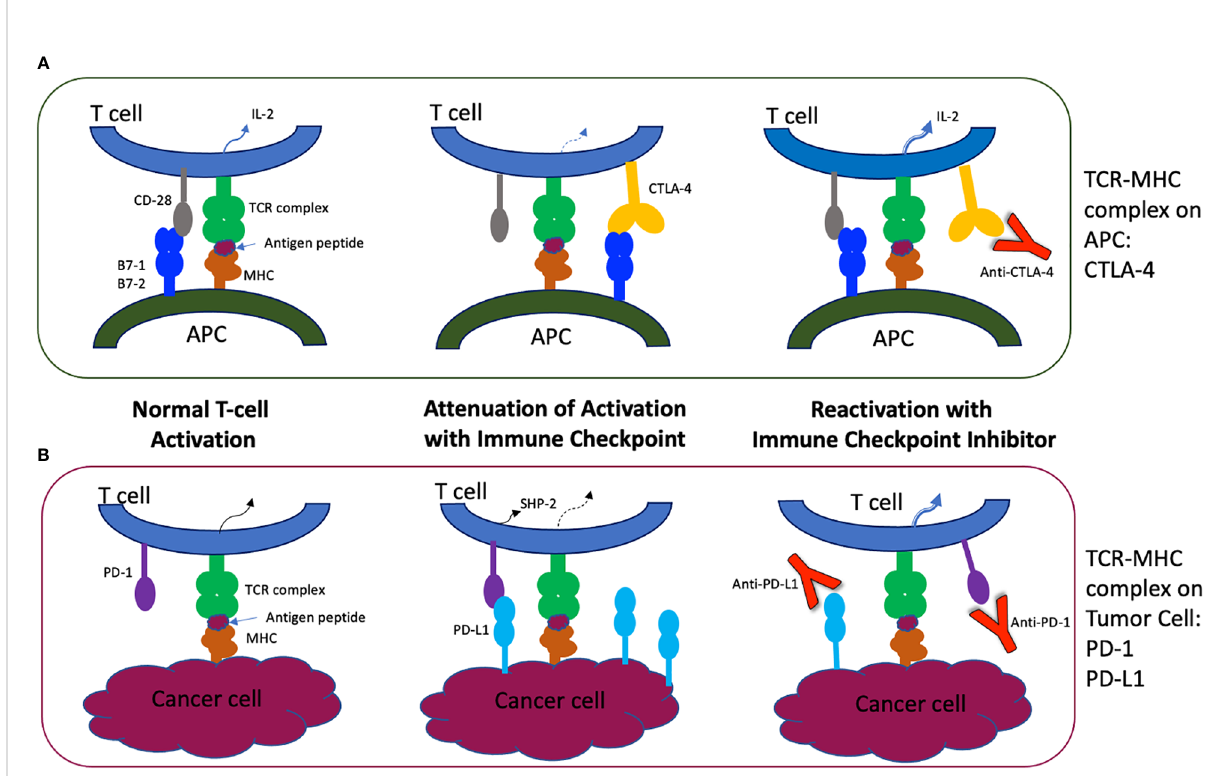
FIGURE 1 Molecular Mechanisms of Immune Checkpoints and Their Inhibitors. (A) The primary activation of the naïve T cell derives from the T cell receptor/CD3 Complex interacting with the antigen presenting cell ’ s MHC Complex, which presents the tumor antigen peptide and stimulates a cytokine cascade within the T cell. CTLA-4 competitively binds to the co-stimulatory molecule CD28, attenuating the T cell activation and providing co-inhibition of the immune response in normal cells. Antibodies targeting CTLA-4 inhibit the co-inhibition pathway, resulting in a more robust and sometimes inappropriate immune activation mediated by unopposed T cell activities. (B) T cells also interact with other APCs and cancer cells through the co-inhibitory interaction of PD-1 with its ligands, PD-L1 and PD-L2 (not shown). Tumor cells may overexpress PD- L1 and lead to over-attenuation of the T cell response via the SHP-2 pathway. Antibodies to PD-1 and PD-L1 restore T cell activation, allowing T cell differentiation and cytokine production but also in fl ammatory side effects (2, 3). CD3, complement domain 3. MHC, major